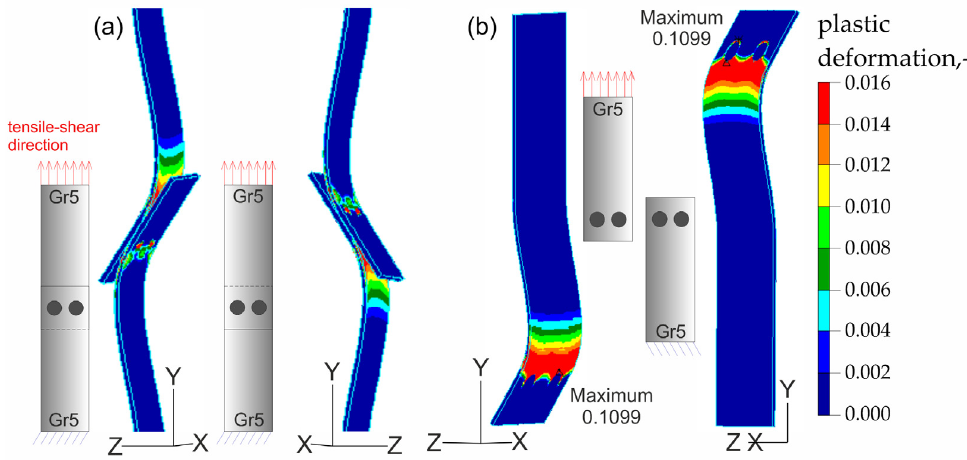
Figure 21. Distribution of plastic deformations in the Gr5–Gr5-3 joints: ( a ) on the surface of the entire joint and ( b ) on the inner surfaces of the joints.